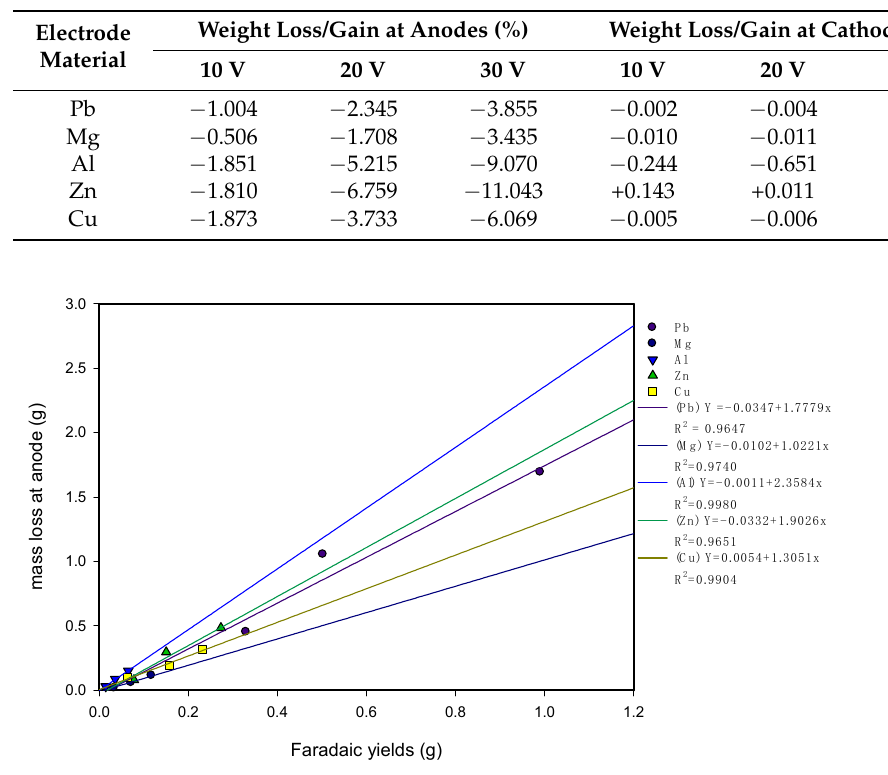
Figure 7. Relationship between the predicted faradaic weight loss at the anodes and the experimental weight loss.